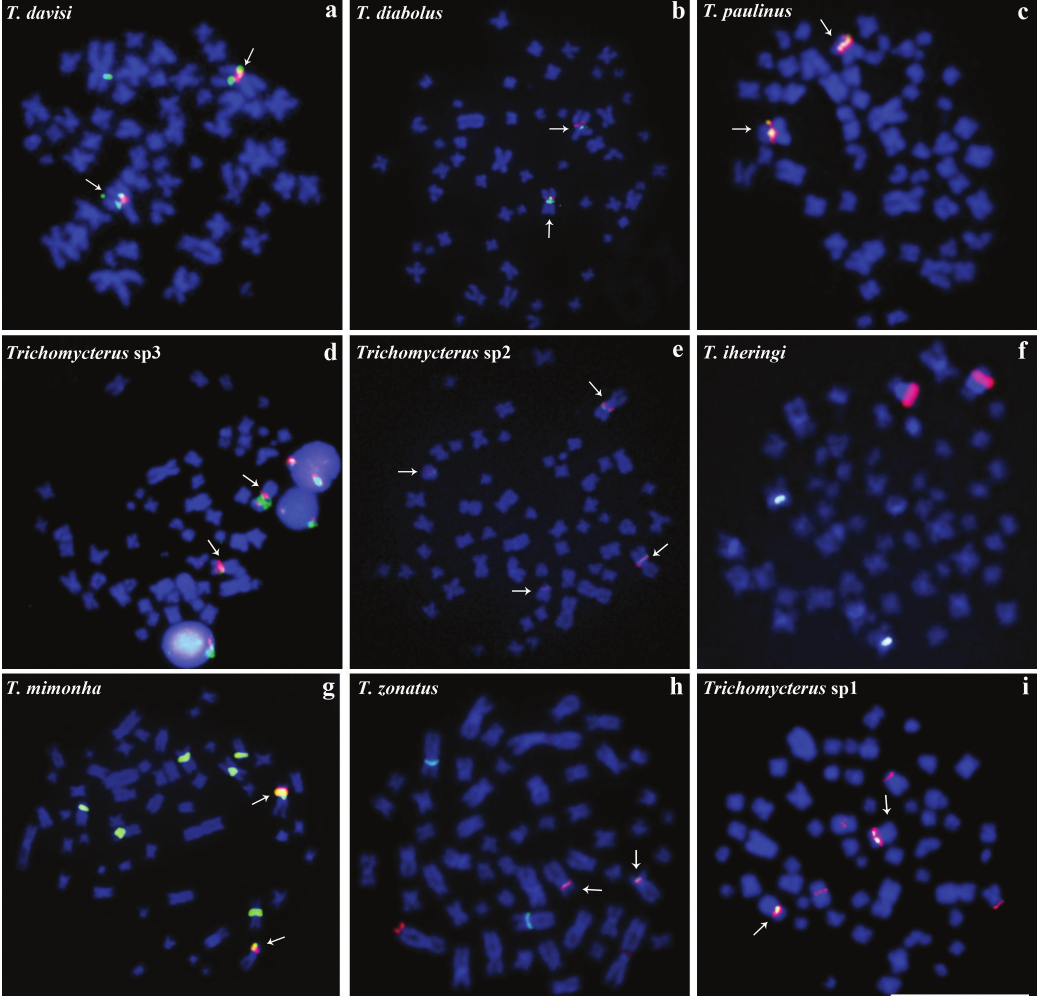
Fig. 3. Distribution pattern of 5S (green) and 18S rDNA sites (red) in metaphase of nine species of Trichomycterus analyzed: a) T . davisi ; b) T . diabolus ; c) T . paulinus ; d) Trichomycterus sp. 3; e) Trichomycterus sp. 2; f) T . iheringi ; g) T . mimonha ; h) T . zonatus ; and i) Trichomycterus sp. 1. Note co-localization between 5S and 18S rDNA sites occurring at least in one chromosome pair in all the species and are evidenced by the white arrows. Bar